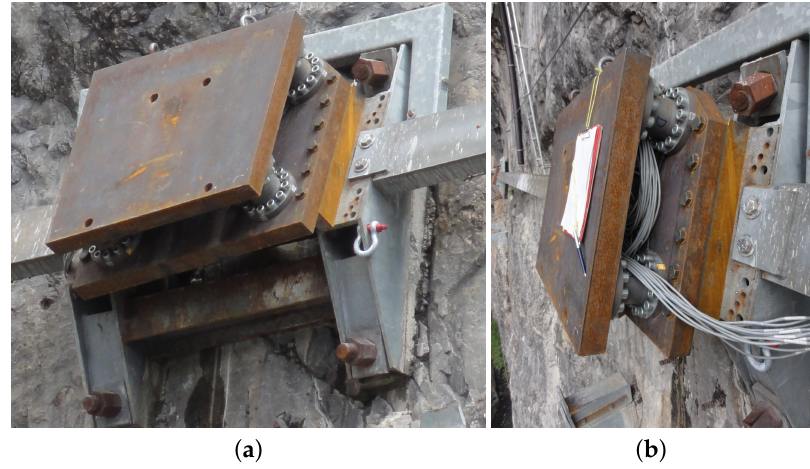
Figure 9. ( a ) Oblique and ( b ) lateral view on mounted sensor unit. Additional steel alignment sheets can be seen between the lower steel plate and the galvanized foundation.